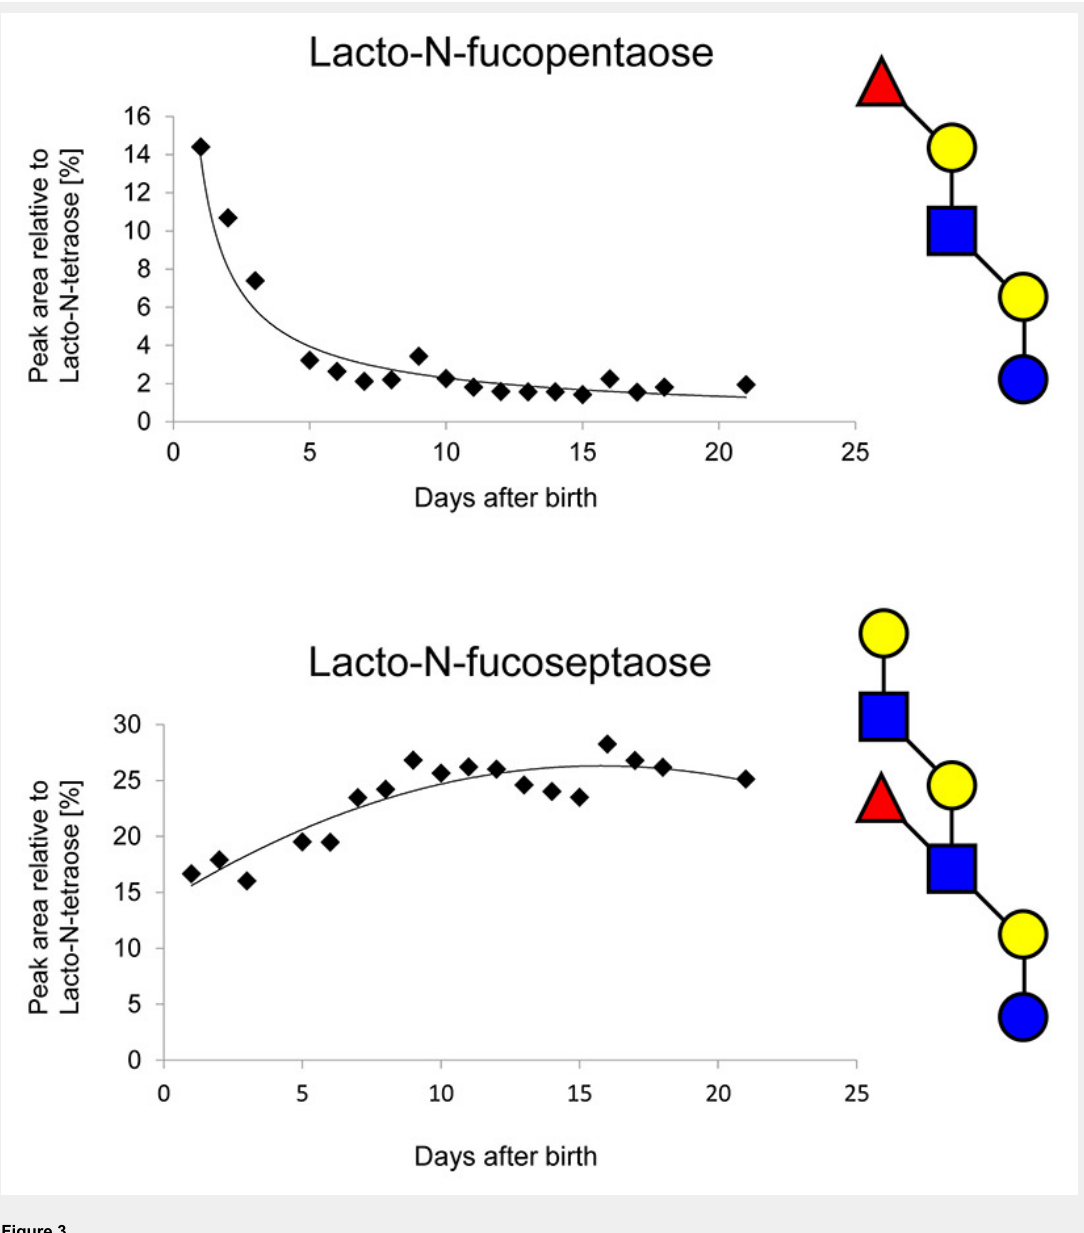
Figure 3 Relative amount of two complex milk oligosaccharides during lactation. The relative levels of the pentasaccharide lacto-N-fucopentaose drop rapidly in the first week of lactation, whereas the relative levels of the heptasaccharide lacto-N-fucoseptaose raise in the first 2 weeks of lactation. Oligosaccharides levels are compared with the constant levels of the milk tetrasaccharide lacto-N-tetraose. The oligosaccharide levels shown were analysed in breast milk samples collected from a single mother over 3 weeks after